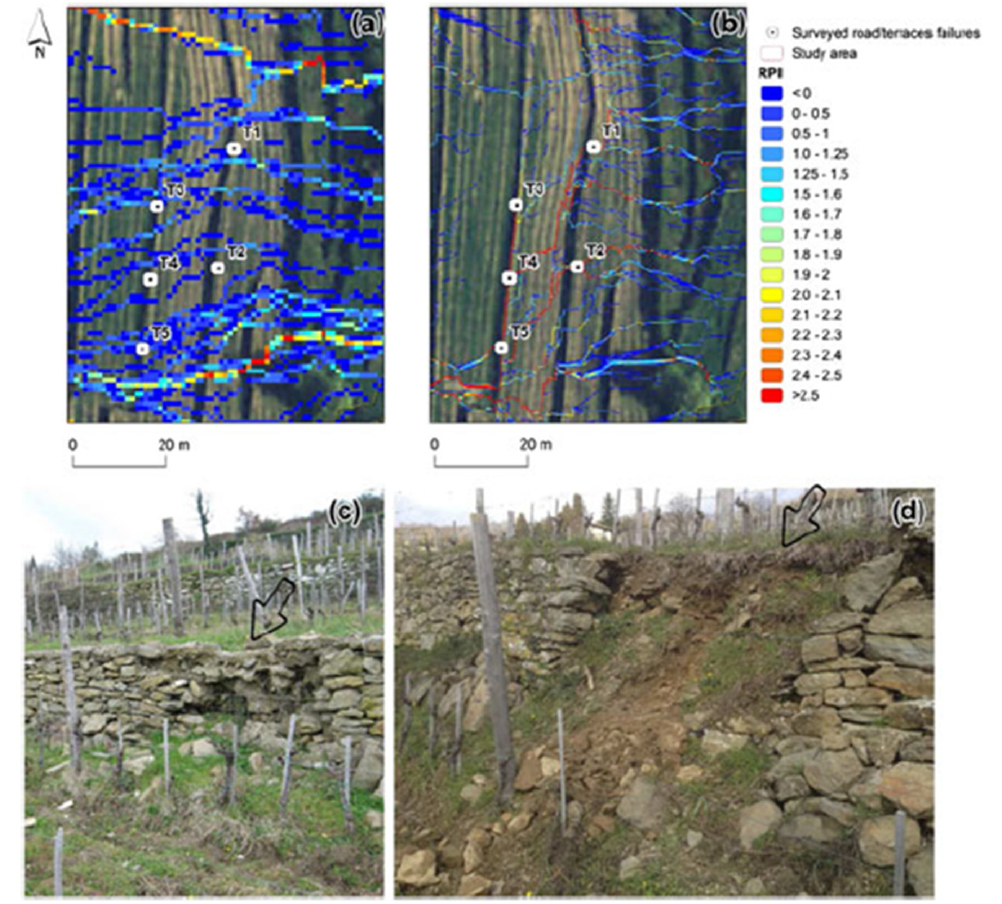
Figure 3. RPII maps derived from the 1 m ALS DTM ( a ) and the 0 · 2 m TLS ( b ), highlighting the flow modifications T1 ( c ) and T5 ( d ). Reprinted with permission from Ref. [10]. Copyright 2015 Wiley.